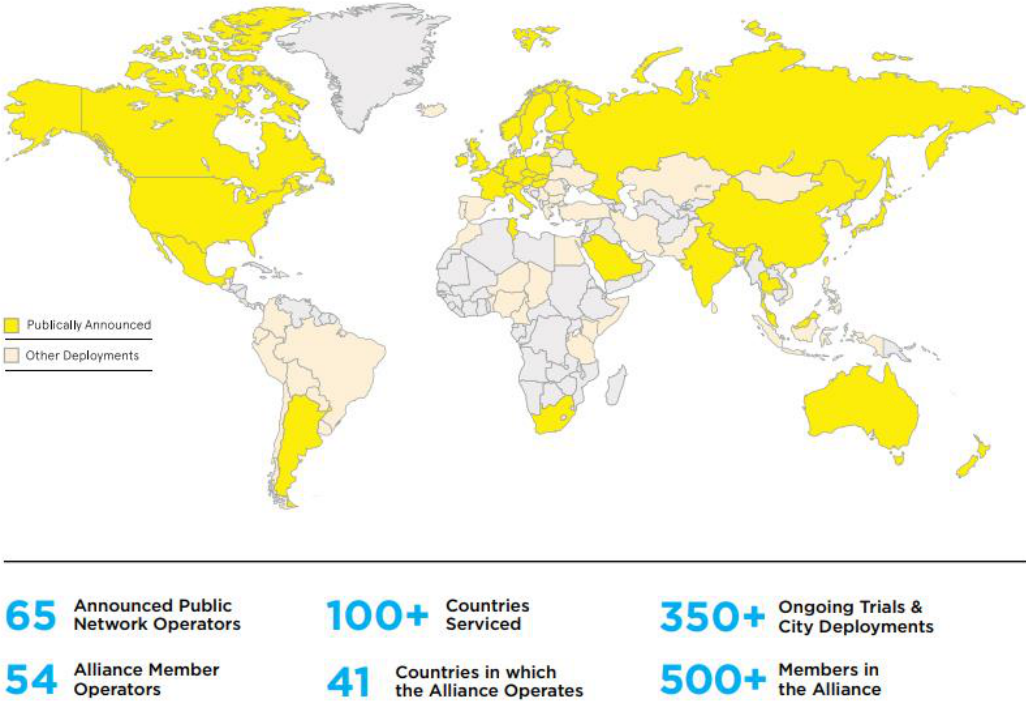
Figure 1. Global distribution of long range (LoRa) usage (which was made by the LoRa alliance and can be found at https://lora-alliance.org/). The dark yellow parts indicate that the application of LoRa technology has been publicly announced, the light-yellow parts indicate that the LoRa technology has a small number of applications, and the light grey parts indicate that the LoRa technology has not yet been applied.